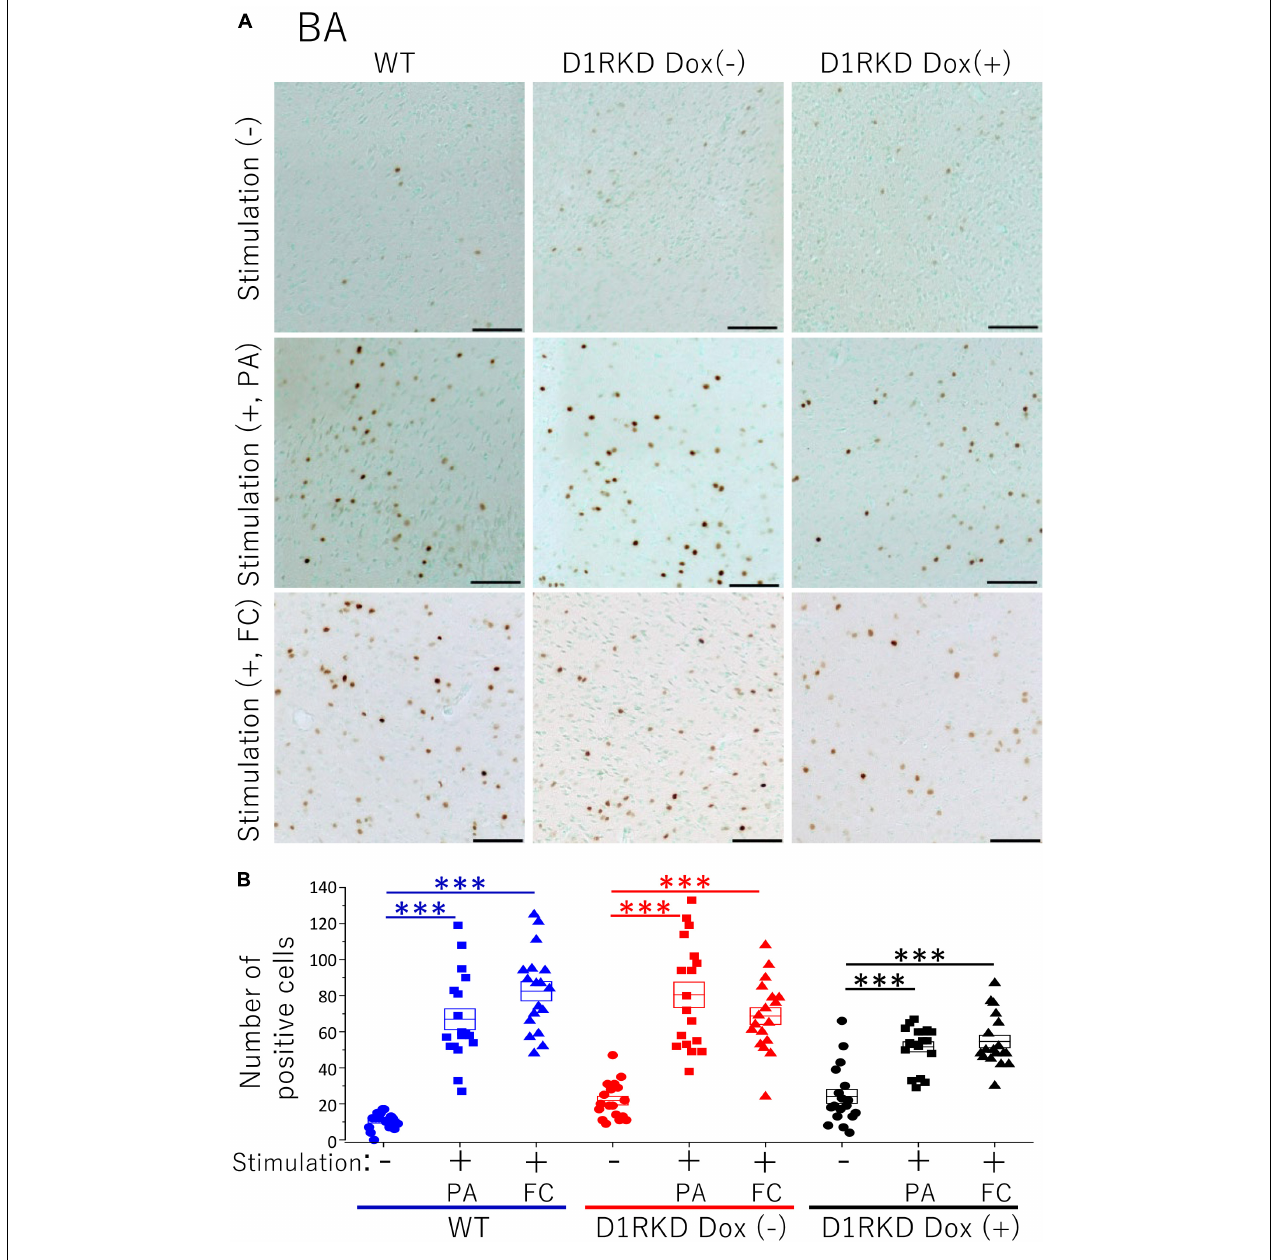
FIGURE 7 | Immunohistochemical analysis of c-Fos expression in BA after 1 h of electric footshock stimulus using a step-through-type apparatus for the passive avoidance test (PA) or fear conditioning system (FC). (A) Representative immunohistochemical staining of c-Fos positive cells. Scale bar, 100 µ m. (B) The number of positive cells in BA in immunohistochemistry. All groups, n = 18. The blue color indicates the values of WT groups, the red color indicates the values of D1RKD Dox (–) groups, and the black color indicates the values of D1RKD Dox (+) groups. The circle, square, and triangle indicate no stimulation, stimulation by PA, and stimulation by FC, respectively, ∗∗∗ p <